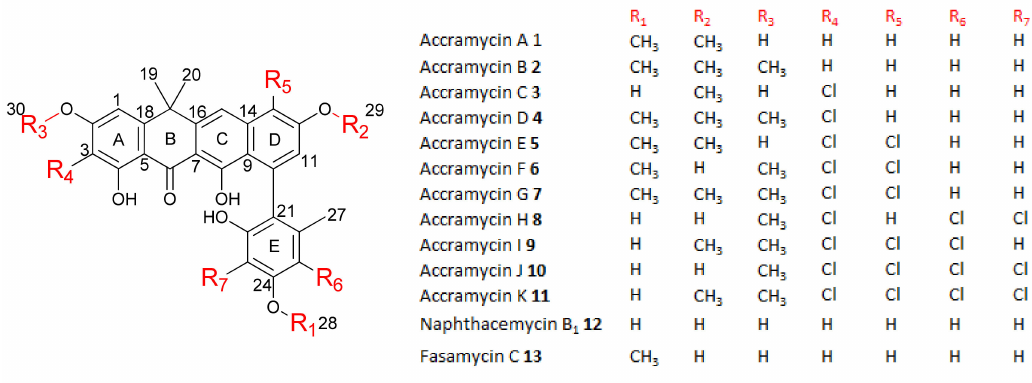
Figure 2. Accramycins A–K, naphthacemycin B 1 and fasamycin C isolated from Streptomyces sp. MA37 ( ∆ accJ )